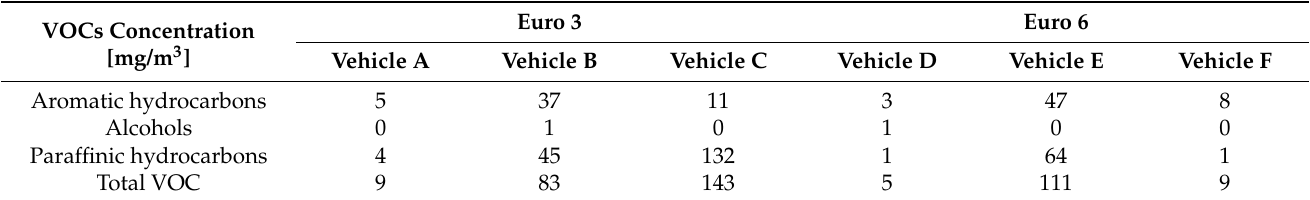
Table 2. Concentrations of the particular VOC groups in the tested